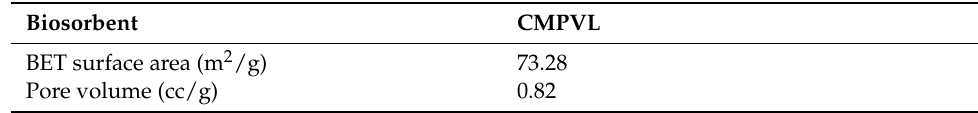
Table 1. Surface area, pore volume and diameter of CMPVL.